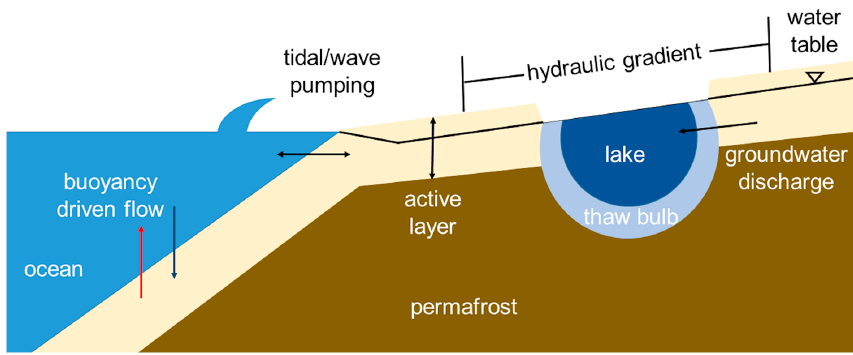
Figure 1. A conceptual model of groundwater discharge in the Arctic, which can be driven by hydraulic gradients, tidal/wave pumping, and buoyancy differences.